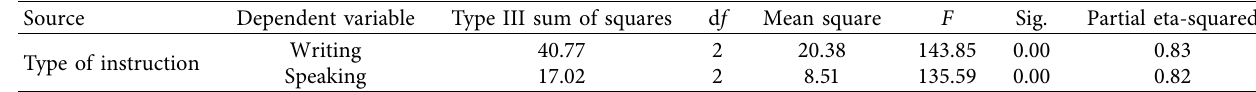
Table 7: Results of tests of between-subjects efects for the type of instruction.